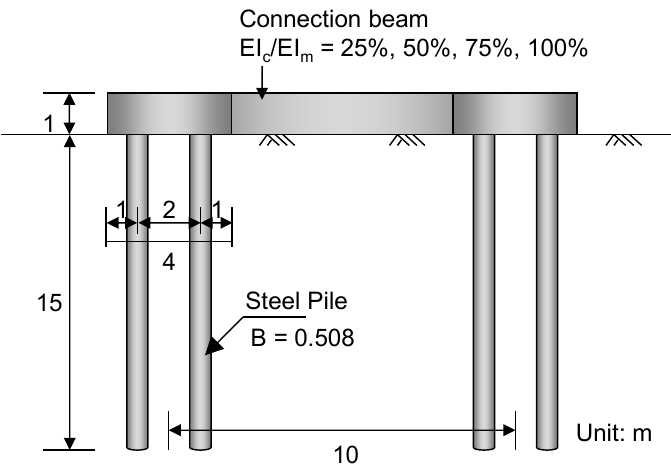
Figure 3. Configuration of foundation parts for finite element